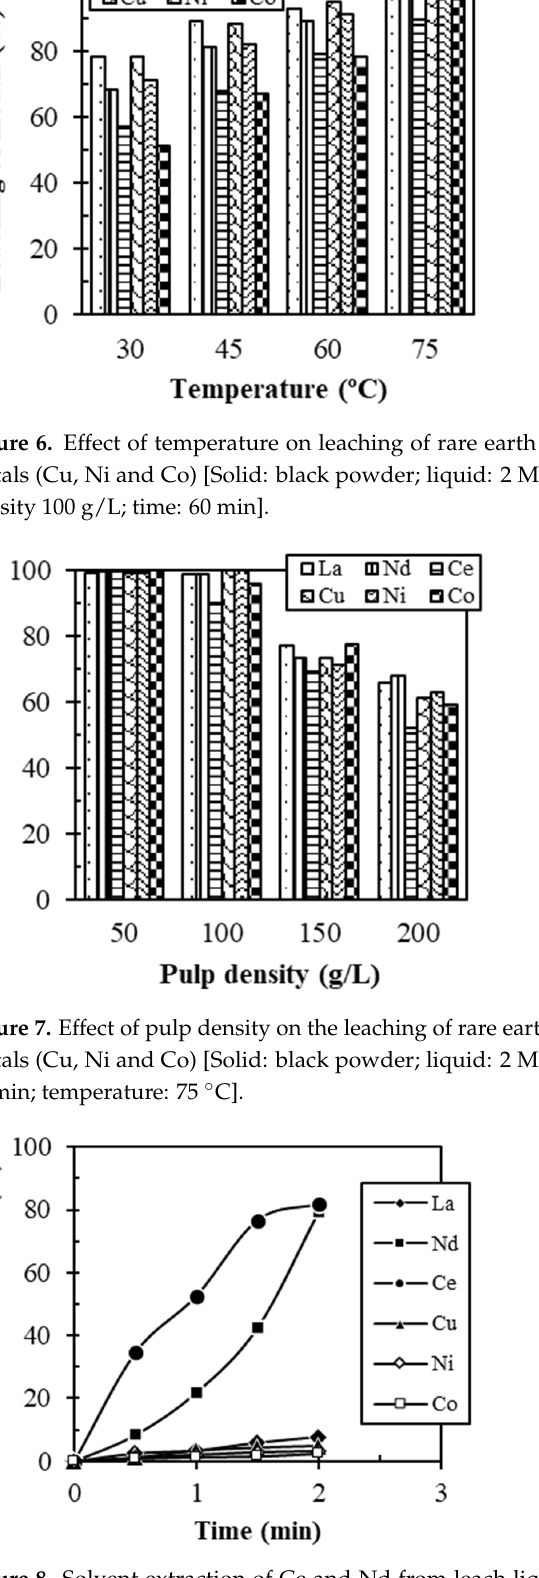
Figure 8. Solvent extraction of Ce and Nd from leach liquor [Metal concentration in leach liquor (g/L): Nd: 3.9; Ce: 11.9; La: 7.6; Cu: 6.5; Ni: 28.9; Co:5.1; extractant: 10% PC88A diluted in kerosene; time: 10 min; O/A ratio: 1/1].